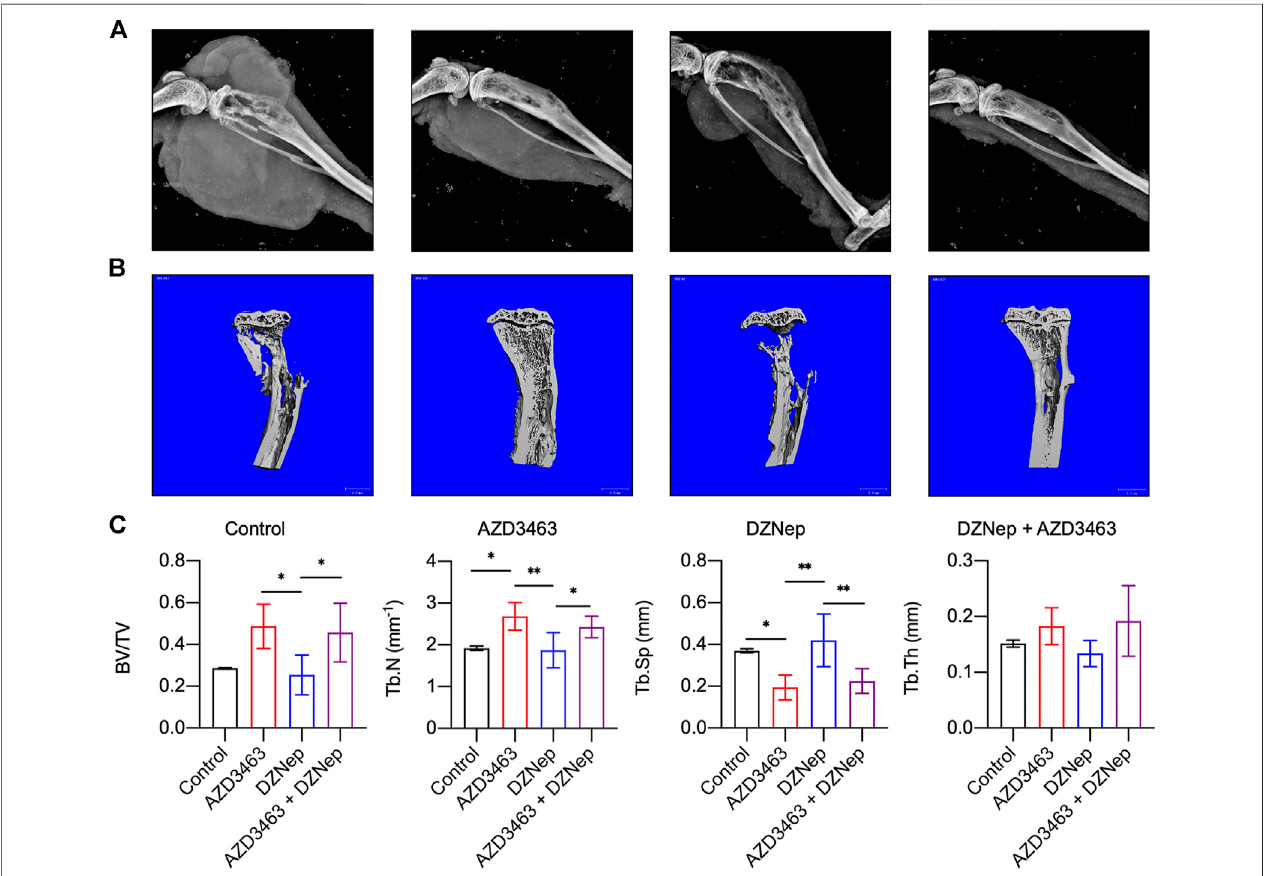
FIGURE 6 | Effects of DZNep and AZD3643 on bone defects due to breast cancer metastasis in vivo . (A) X-ray images of left hindlimbs showing small tumor volumesinAZD3463(7.5 mg/kg)andDZNep(2 mg/kg)groups,andminimumtumorvolumeinthecombination(7.5 mg/kgAZD3463and2 mg/kgDZNep)group.Bone defects wereless apparentin theAZD3463 and combination groups than thecontroland DZNep groups. (B,C) Micro-computedtomography (CT) indicated higher BV/ TV, Tb.Th, and Tb.N and lower Tb.Sp in the AZD3463 and combination groups than the control and DZNep groups.